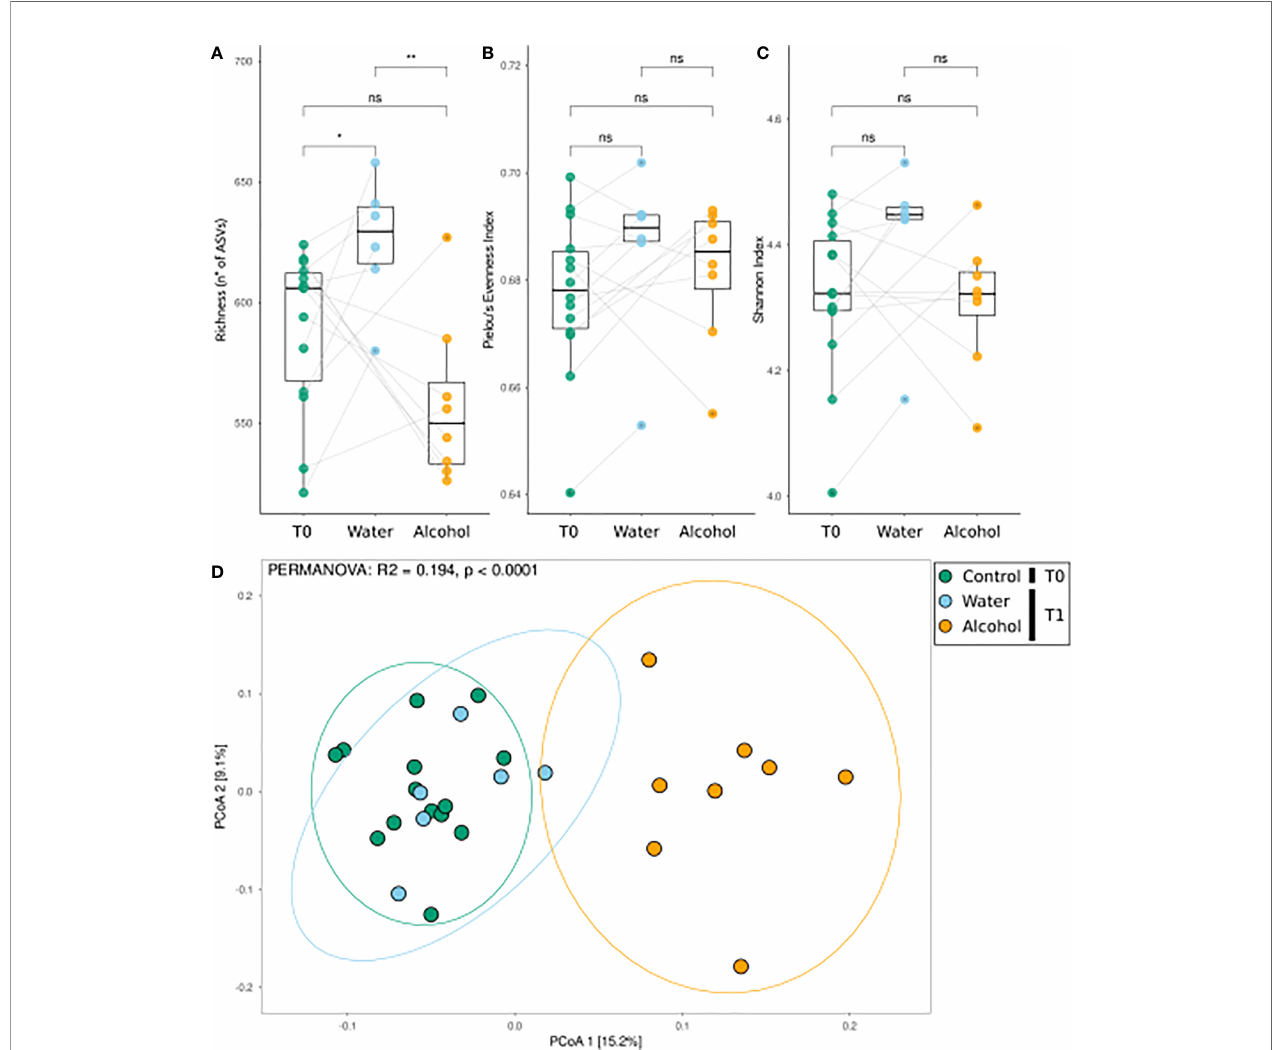
FIGURE 1 | Bacterial community response to alcohol binge drinking. Analyses were performed on the non-OEA-treated sample subset, including the T1 alcohol- and water-administered rats, and the corresponding T0 samples. (A) Richness [number of different amplicon sequence variances (ASVs)], (B) Pielou ’ s evenness index (equitability of the distribution of relative abundances among ASVs), and (C) Shannon index (diversity of the community) as measures of a -diversity. Differences between groups were tested by the Wilcoxon rank-sum test and reported as notation on the plot (ns, p -value > 0.05; * p -value < 0.05; ** p -value < 0.01). Dotted lines connect the data from the same animal at the two time points for each treatment. (D) b -Diversity analysis with PCoA ordination using the Bray – Curtis distance measure. T0 group, n = 14; water group, n = 6; alcohol group, n = 8. Notation above the plots reports the result of the PERMANOVA